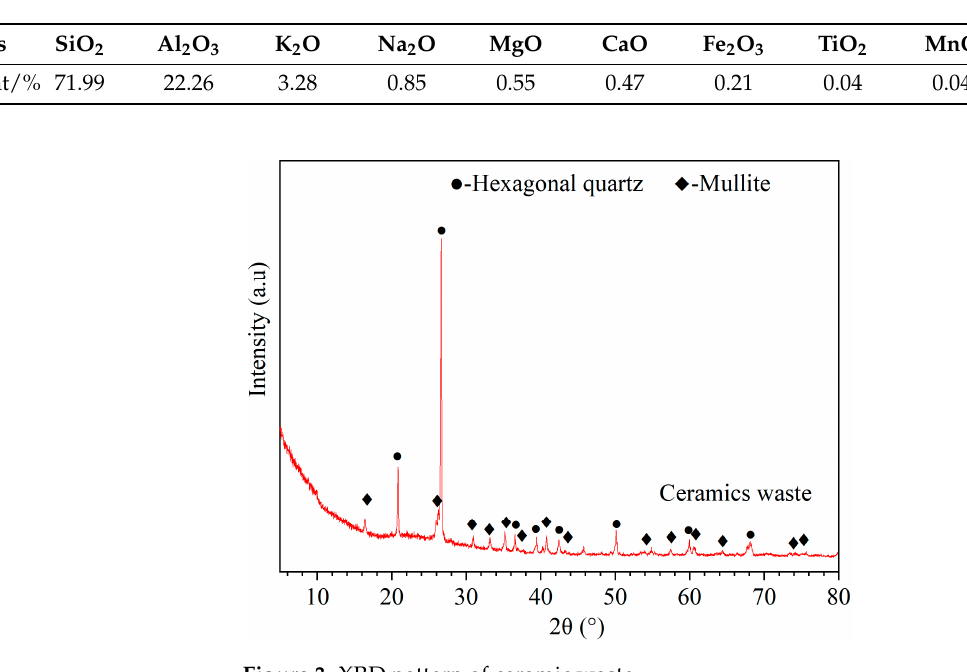
Figure 3. XRD pattern of ceramic waste.